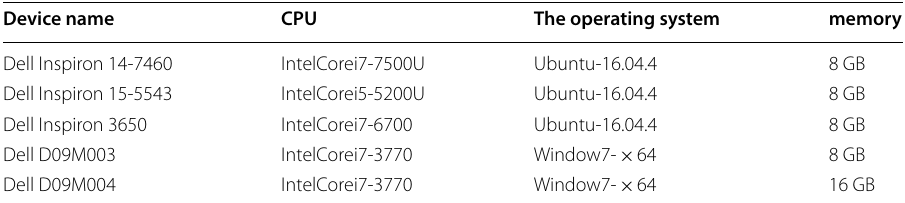
Table 1 Computer equipment specifications